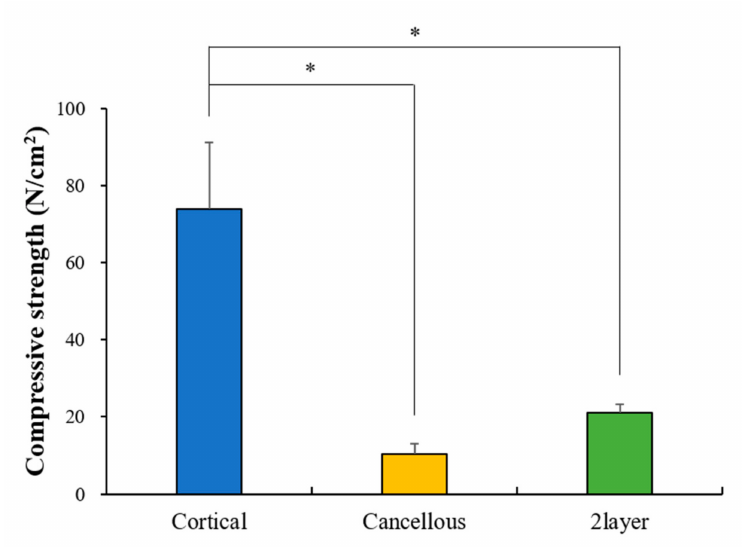
Figure 2. Compressive strength result (* p < 0.05; n = 10).